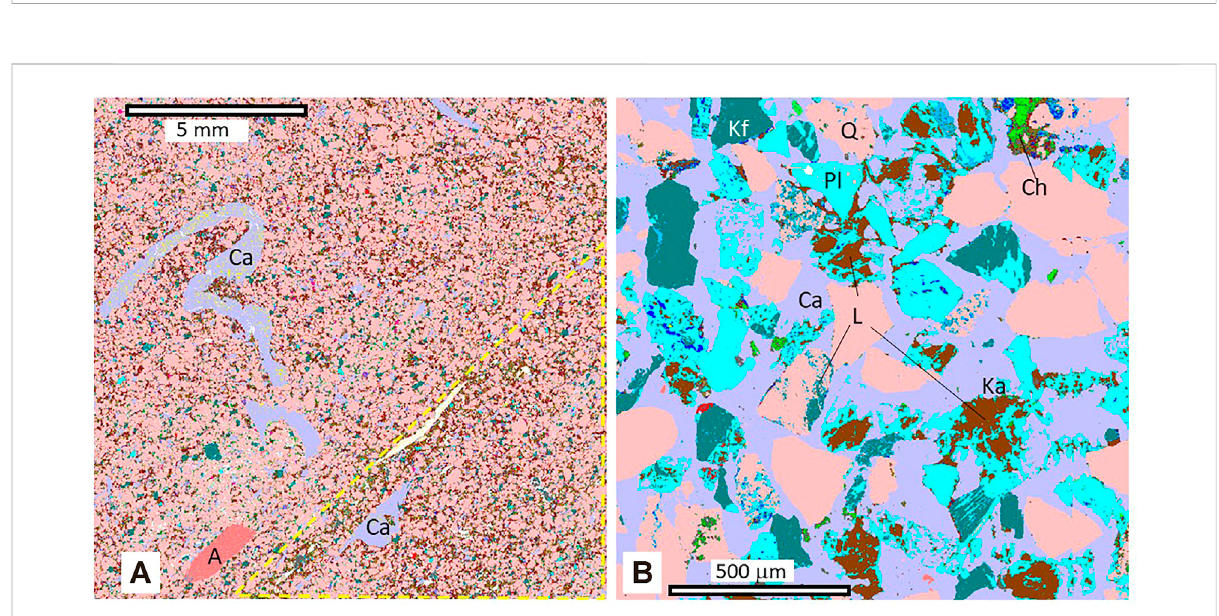
FIGURE 8 Calcite in sandstones (mineral colour index in Figure 3). (A) Low porosity Upper Jurassic shallow marine, quartz-rich sandstone from the Weald Basinwithcalcite(Ca)presentasbothrecrystallisedcarbonatebioclasts(seecomplexshapecentreleft)andpore- fi llingcement.Thesandstonealso contains detrital apatite (A) (probably a tooth or bone fragment) and illite-rich clay-rich patches (yellow dashed outline) that probably represent burrows. (B) Low porosity Upper Triassic deltaic sandstones from the Ordos Basin, China with abundant quatz (Q), plagioclase (PL), K-feldspar (Kf) and lithic (L) grains as well as detrital quartz. The patches of chlorite (Ch) were probably from basic igneous rock fragments. This sandstone is extensively cemented with calcite that has fi lled both primary and secondary